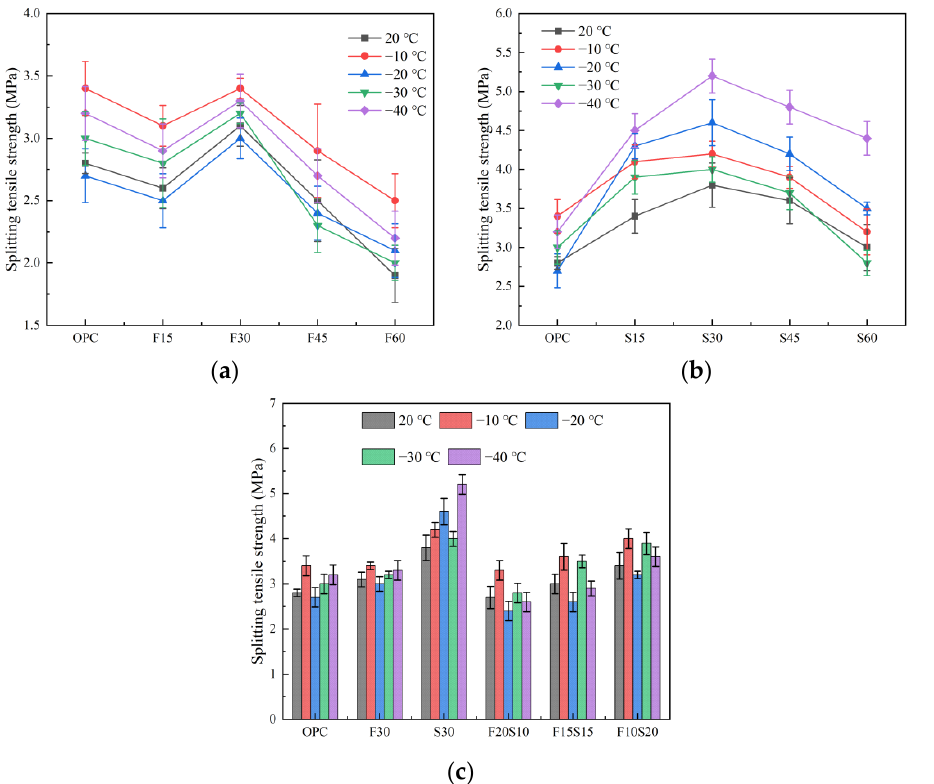
Figure 5. Splitting tensile strength of the concrete. ( a ) Mixed with fly ash, ( b ) mixed with slag, and ( c ) mixed with fly ash and slag.